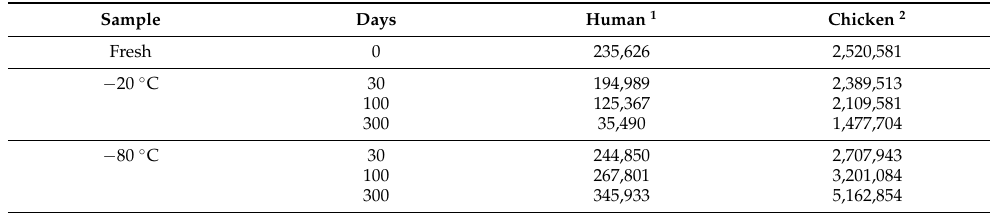
Table 1. Predictions derived from a Poisson model of the effects of storage duration and temperature on counts of E. coli colonies in fresh and freeze-stored human and chicken samples.